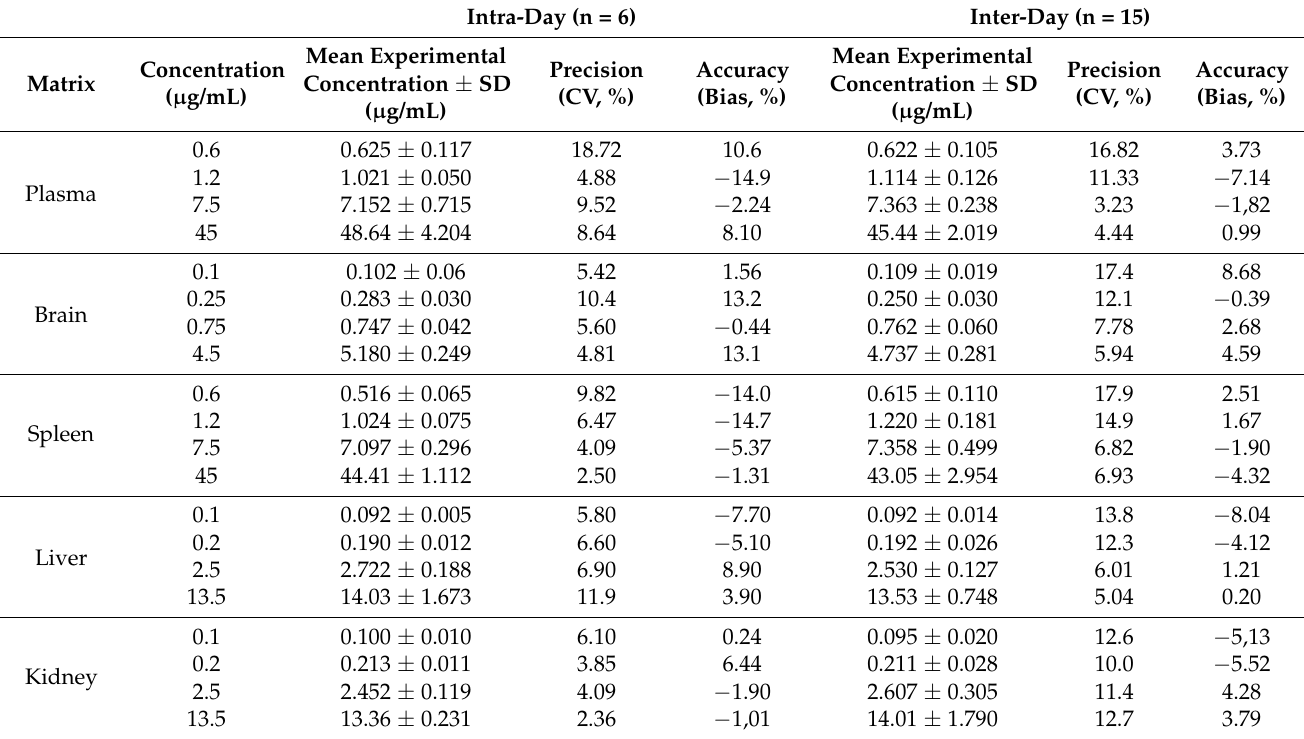
Table 4. Intra- and inter-day precision and accuracy results obtained for celecoxib in mouse matrices at the concentrations of the lower limit of quantification (LLOQ), at the low (QC1), middle (QC2), and high (QC3) concentrations of the calibration